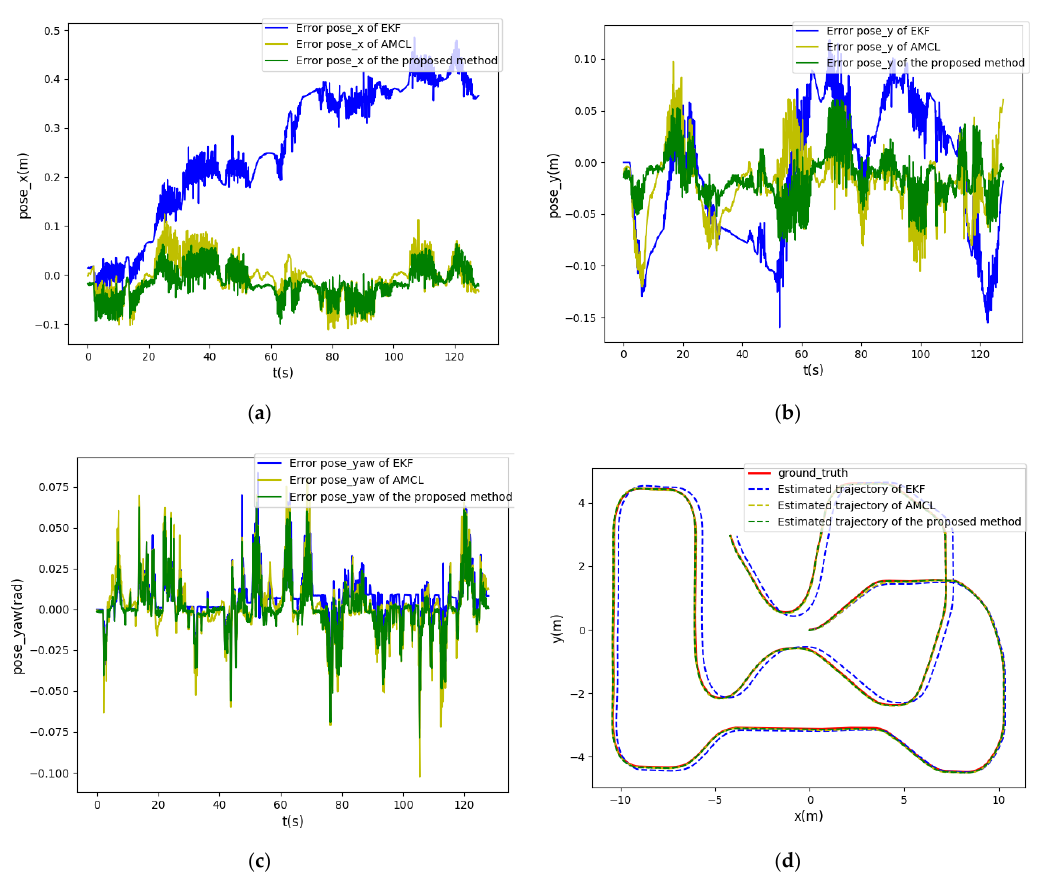
Figure 12. The pose estimation result of case 2. ( a ) The estimated error in x direction; ( b ) The estimated error in y direction; ( c )The estimated error in the yaw direction; ( d ) True trajectory and esti- mated trajectory.